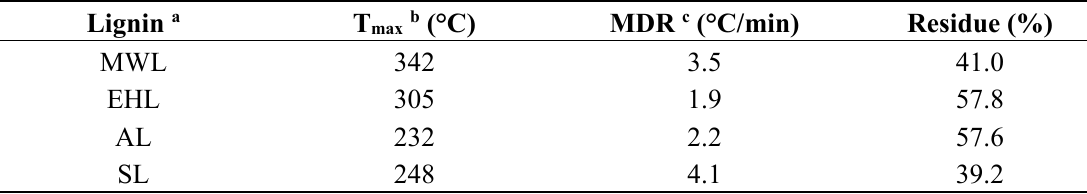
Figure 1. Curves of TGA and DTG for four different lignins, all at a heating rate of 10 °C/min. MWL: milled wood lignin; EHL: enzymatic hydrolysis lignin; AL: alkali lignin; SL: sulfonate lignin. Table 1. Characteristic points on the TGA and DTG curves of the four lignins used in pyrolysis